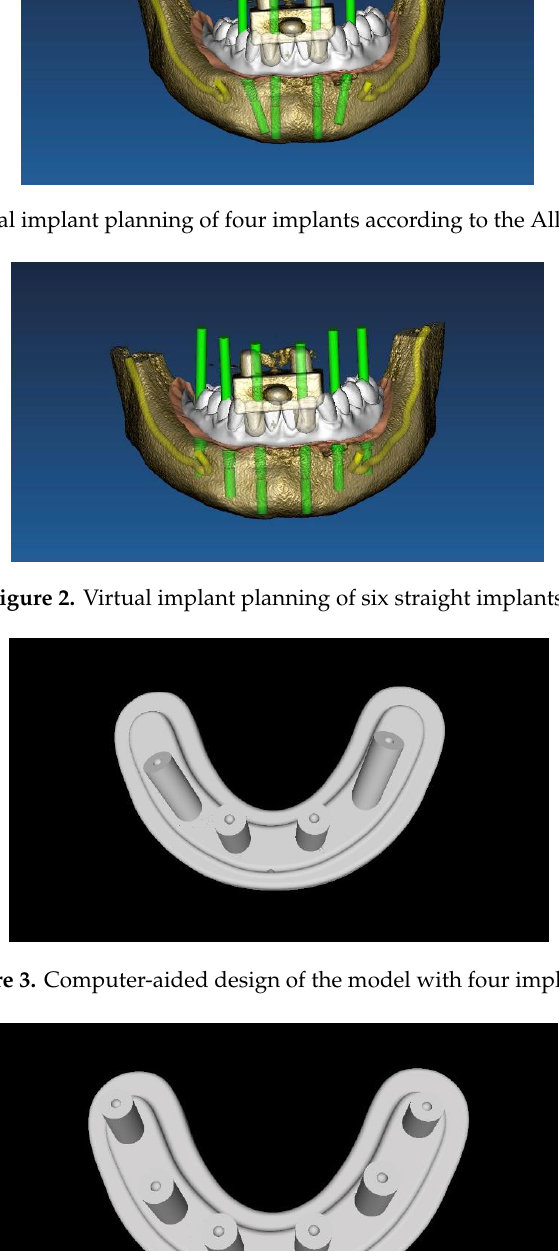
Figure 4. Computer-aided design of the model with six implants.